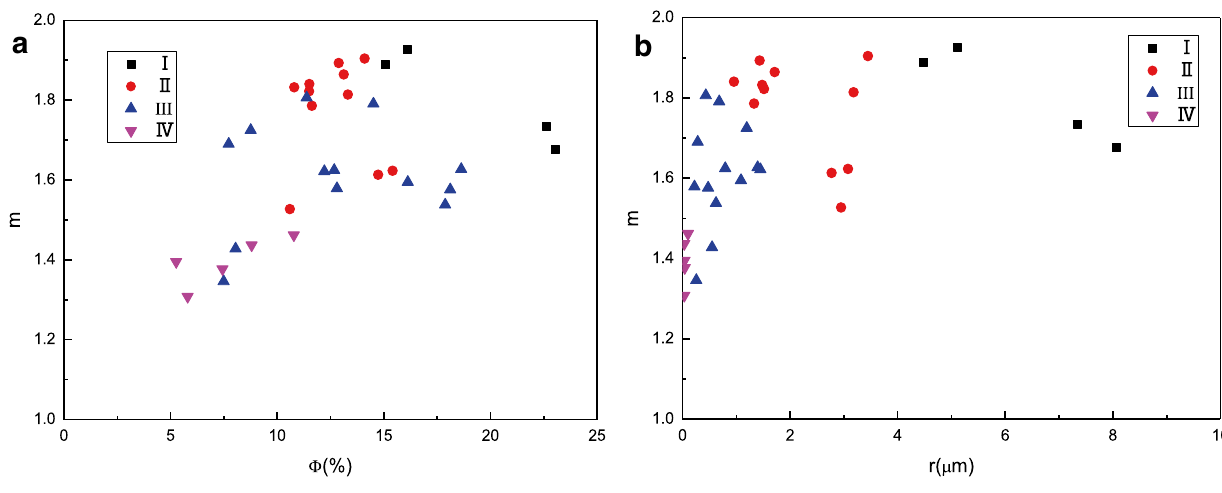
Fig. 12 a m – Φ relationship of rock with different pore structures; b m – r relationship of rock with different pore structures